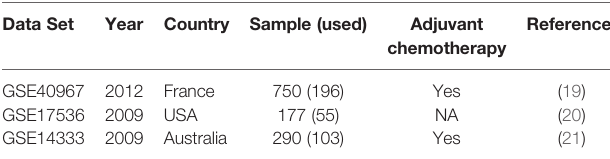
TABLE 1 | Characteristics of three public gene expression data